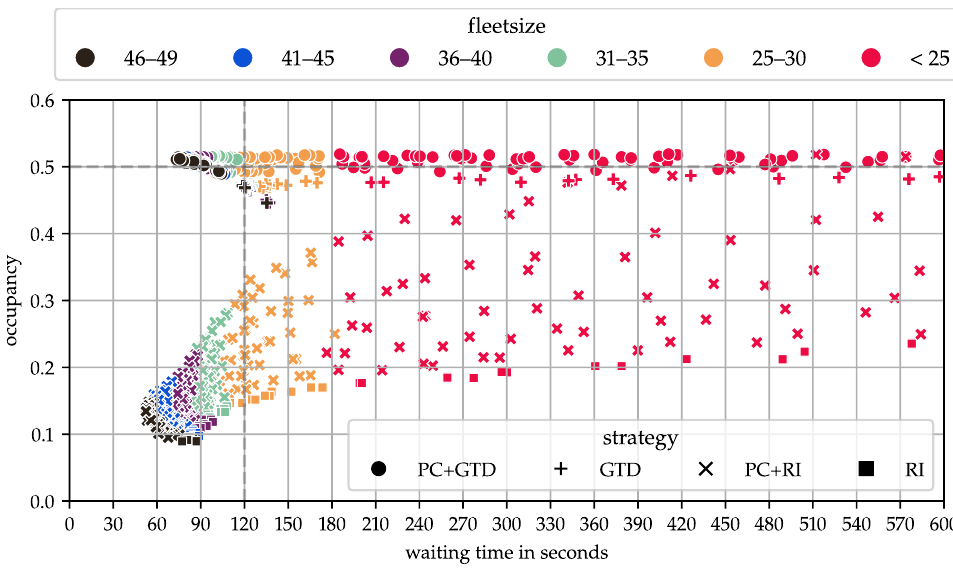
Figure 6. Occupancy of PRT systems with different fleetsizes and operating